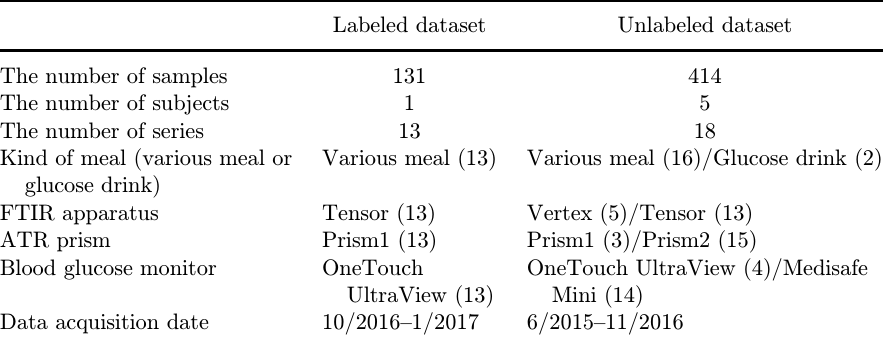
Table 1. Dataset properties.